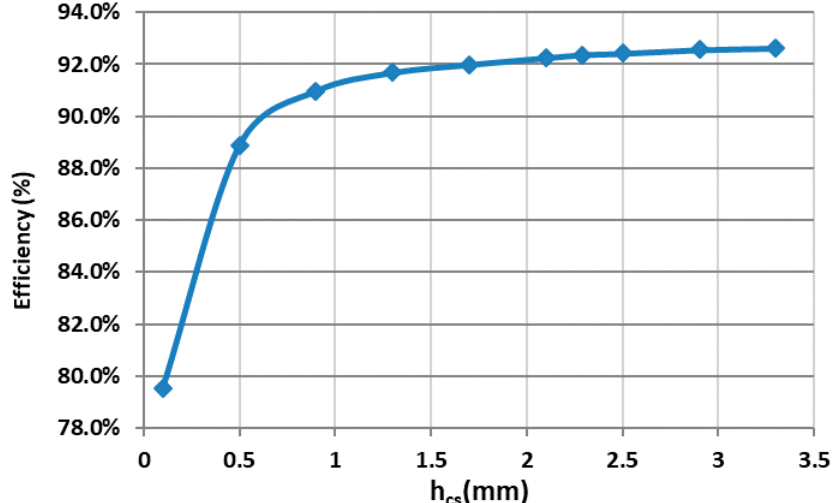
Figure 35. FEA results for h cs effect on Efficiency.